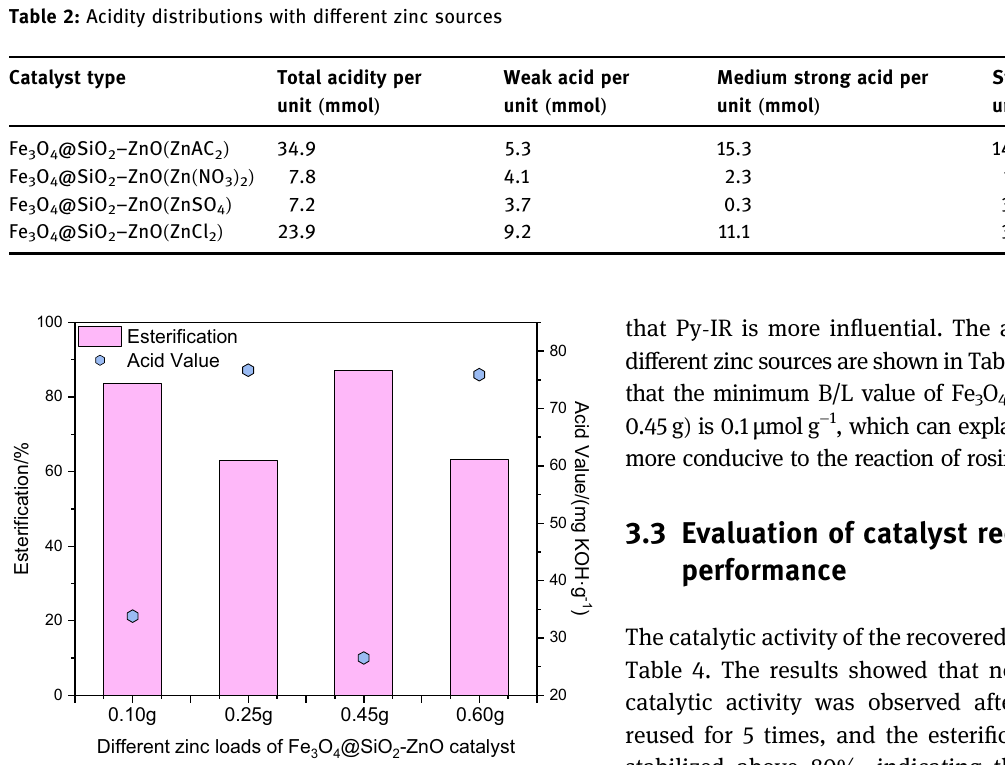
Table 2: Acidity distributions with di ff erent zinc sources